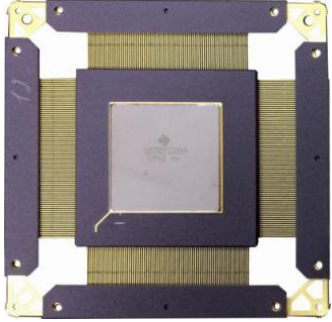
Fig. 3. 5578ТС094 FPGA